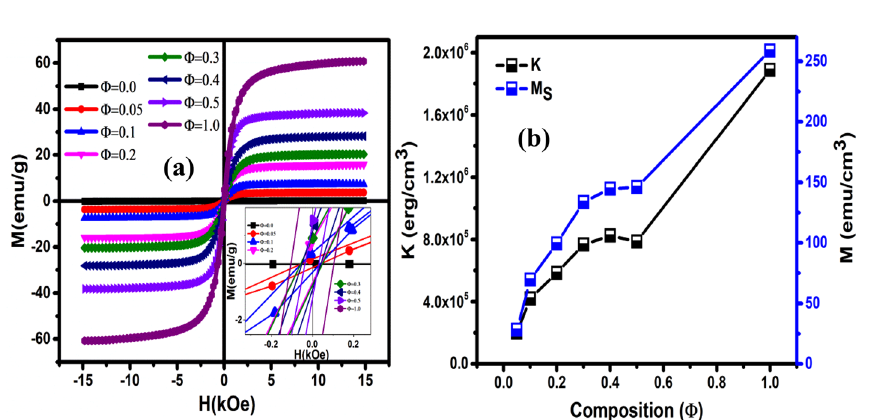
Figure 4. ( a ) The variations of magnetization (M) with magnetic field (H) at RT for all the compositions. Inset shows the enlarged view of the graph. ( b ) Variation of anisotropy constant (K) and saturation magnetization (M S ) with composition obtained from LAS